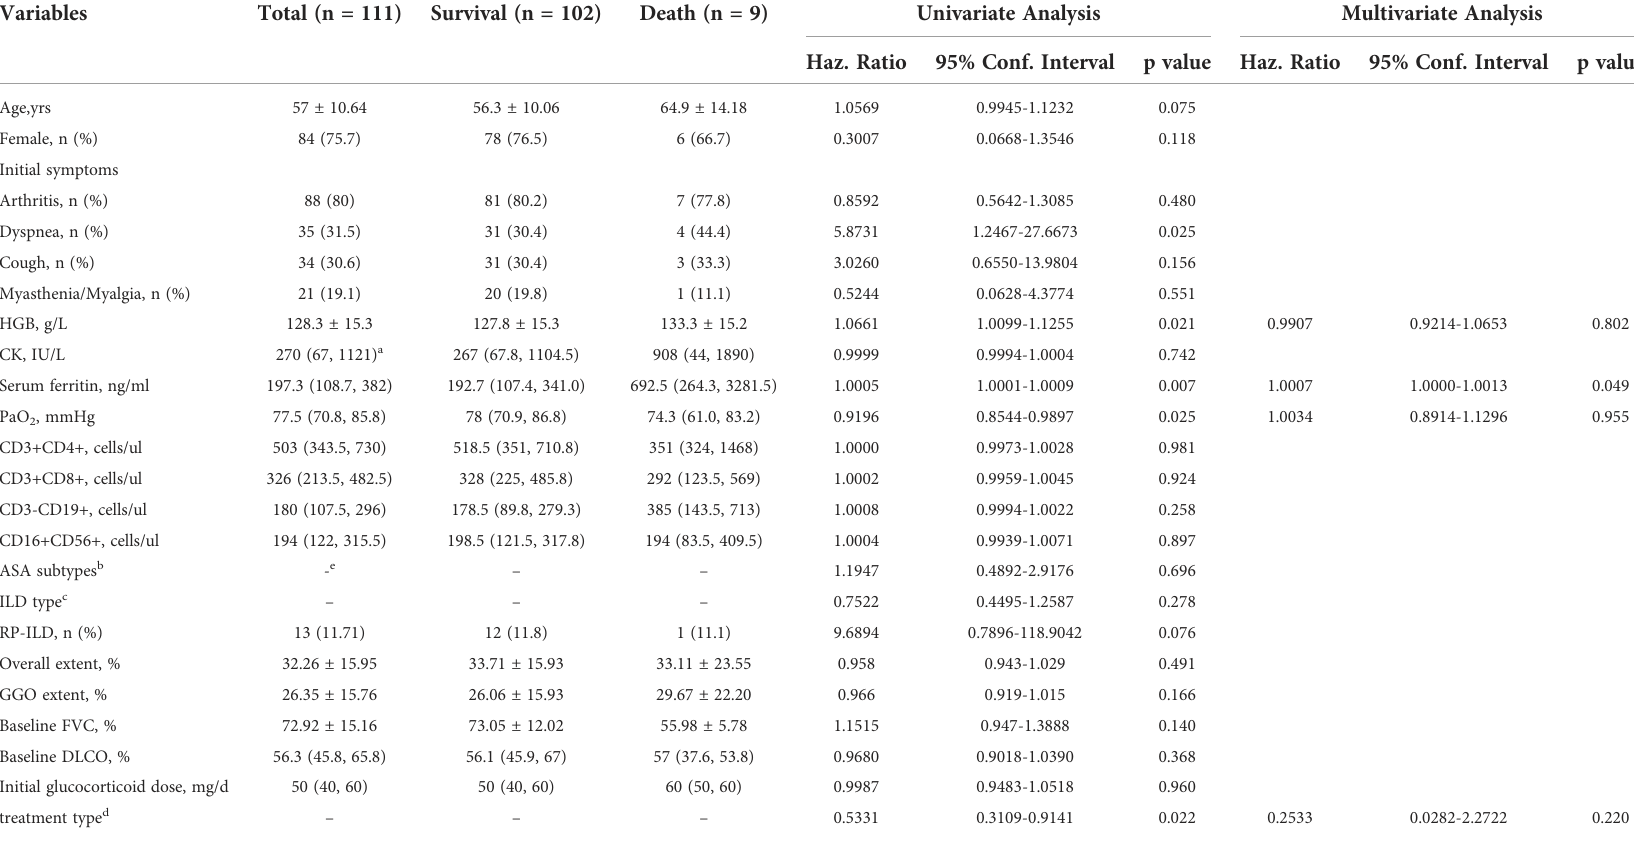
TABLE 5 Analysis on the survival factors patients with